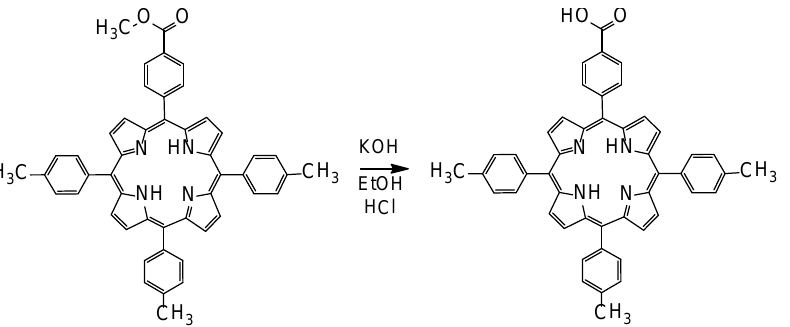
Figure 2. Hydrolysis reaction of porphyrin ester (5-COOCH3-3MPP) to carboxyl substituted deriva- tive (5-COOH-3MPP).